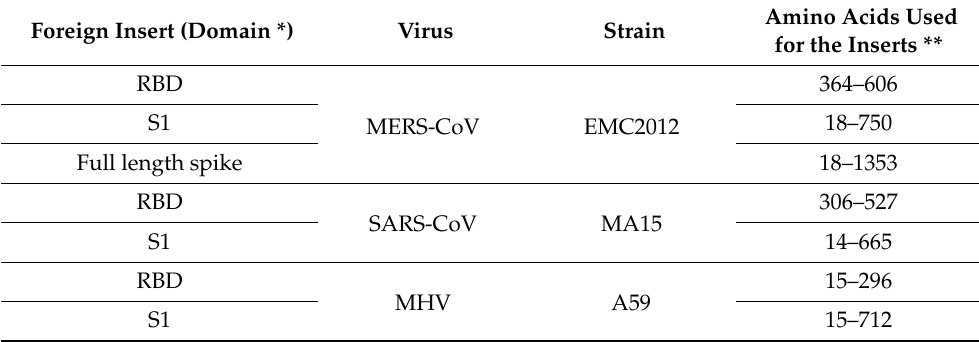
Table 1. Foreign protein inserts, derived from the spike proteins of MERS-CoV, SARS-CoV and MHV, inserted in the